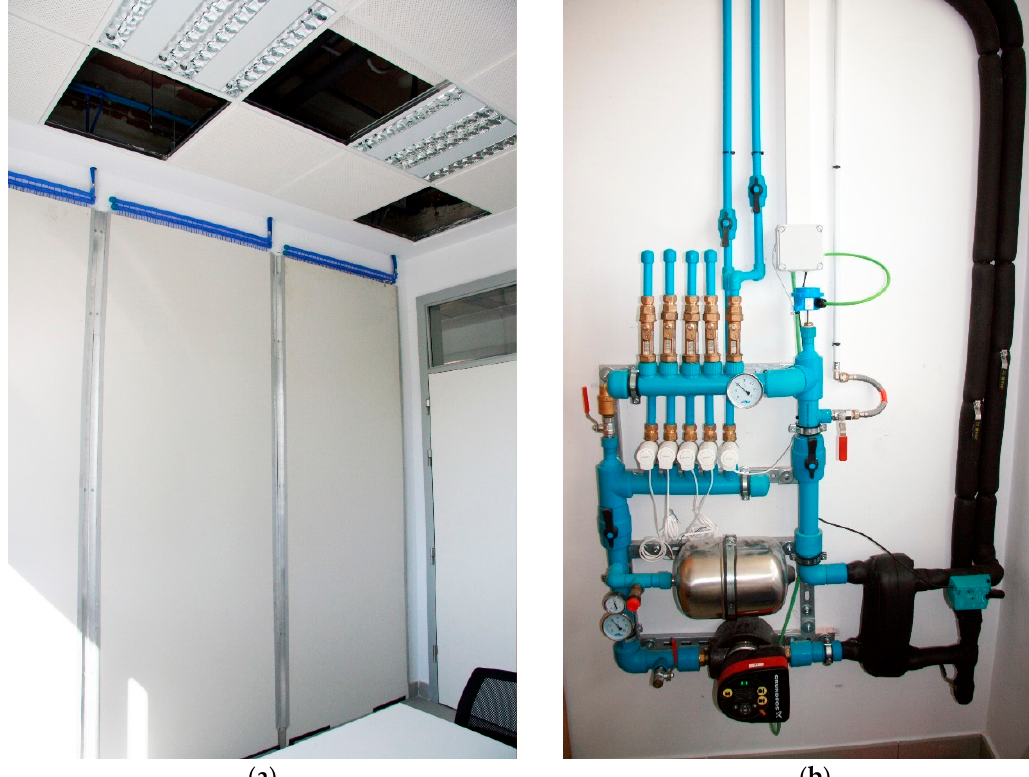
Figure 2. A thermal ceramic panel (TCP) in an office at Alicante University. ( a ) Distribution management substation. TCP panels in the standard office of the Multipurpose III building. University of Alicante; ( b ) Substation for management and control of distribution circuits.